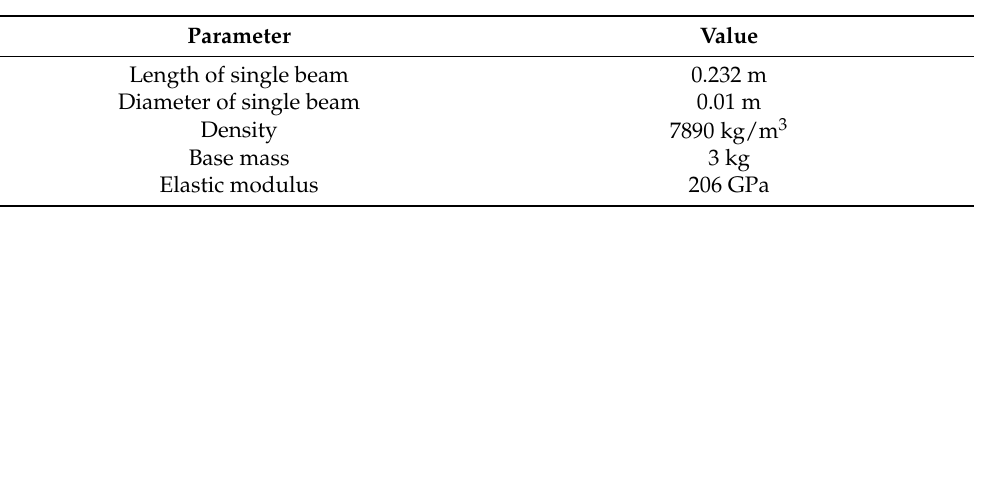
Table 1. Parameters of measuring